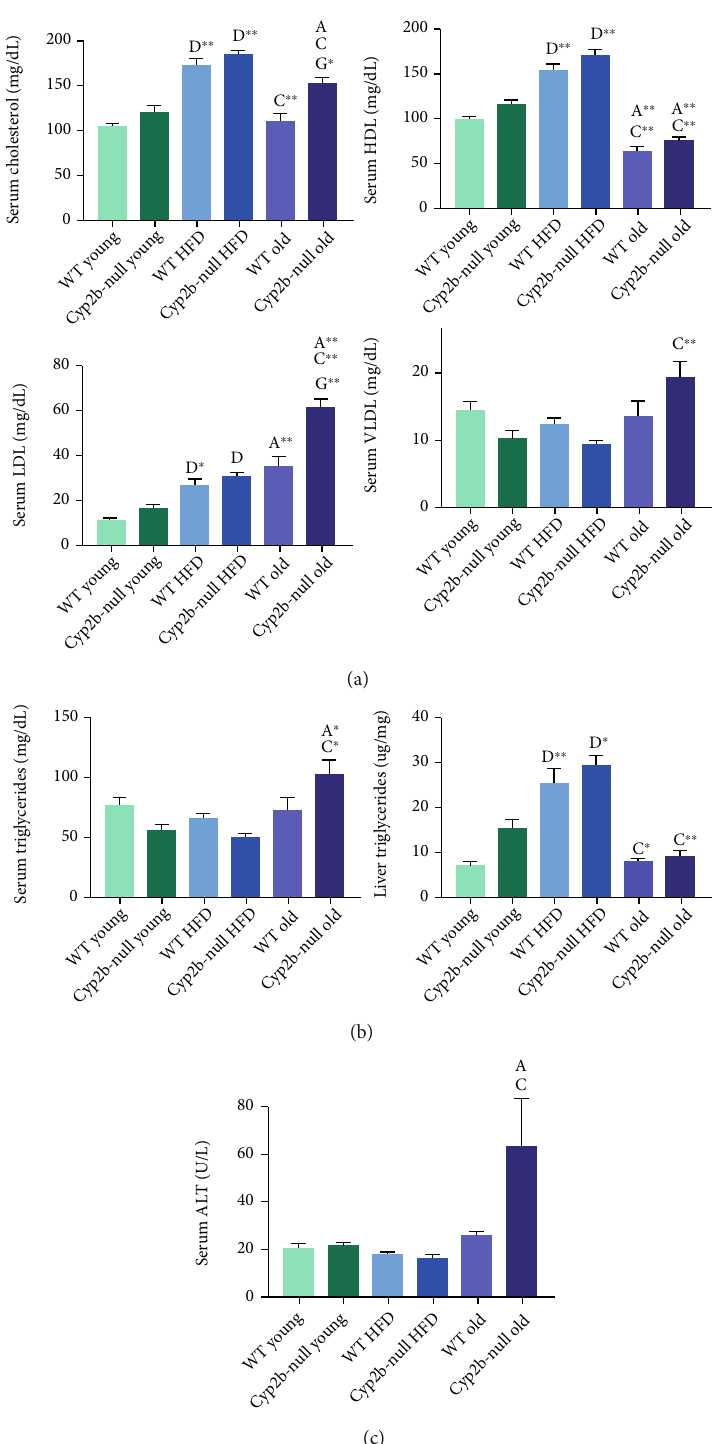
Figure 2: Perturbations in serum lipids, liver triglycerides, and alanine aminotransferase (ALT) with age, diet, and genotype. Serum cholesterol, HDL, LDL, and VLDL (a), serum and liver triglycerides (b), and serum ALT (c) were measured in all treatment groups using standard methods. Data are presented as mean ± SEM . Statistical signi fi cance was determined by one-way ANOVA followed by Tukey ’ s multiple comparison test as the post hoc test ( n = 5 − 6 ). “ a ” indicates age di ff erence comparing young (4.5mo) and old (9 mo) mice within the same genotype and diet group, “ c ” indicates di ff erence between HFD-fed young (4.5mo) and ND-fed old (9 mo) mice within same genotype, “ d ” indicates diet di ff erence between ND-fed and HFD-fed mice within in same genotype and age, and “ g ” indicates genotype di ff erence between WT and Cyp2b-null mice within same diet and age group. No asterisk indicates a p value < 0.05, ∗ indicates a p value < 0.01, and ∗∗ indicates a p values <